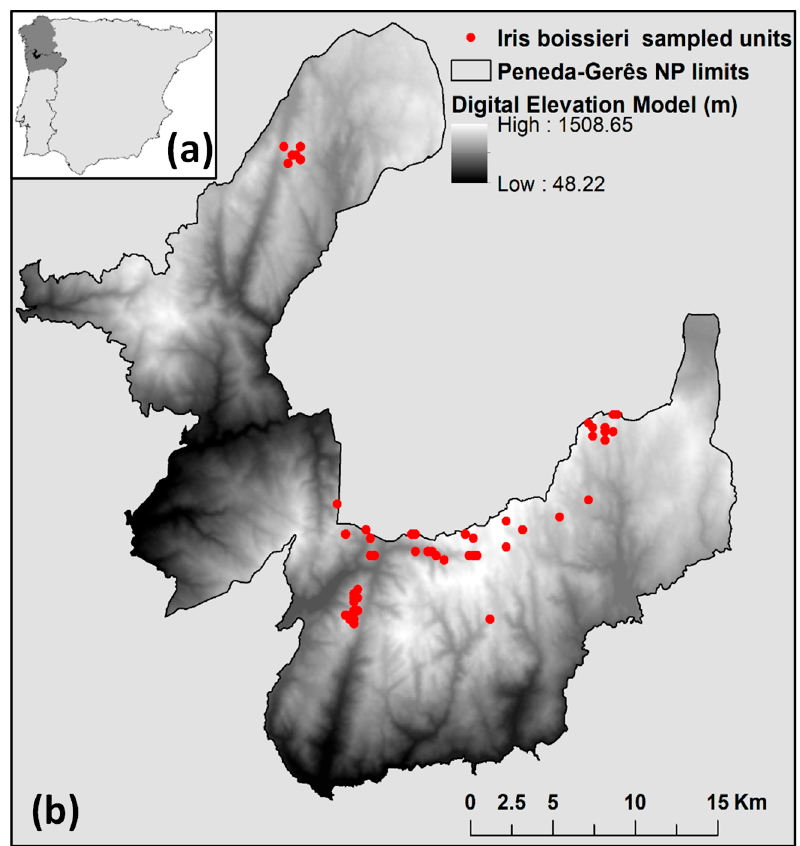
Figure 1. Location of the study area (the Peneda-Gerês National Park) in the northwest Iberian Peninsula ( a ). Distribution of the sampled units of Iris boissieri in 2006 for each grid unit (250 × 250 m) in the study area ( b ).